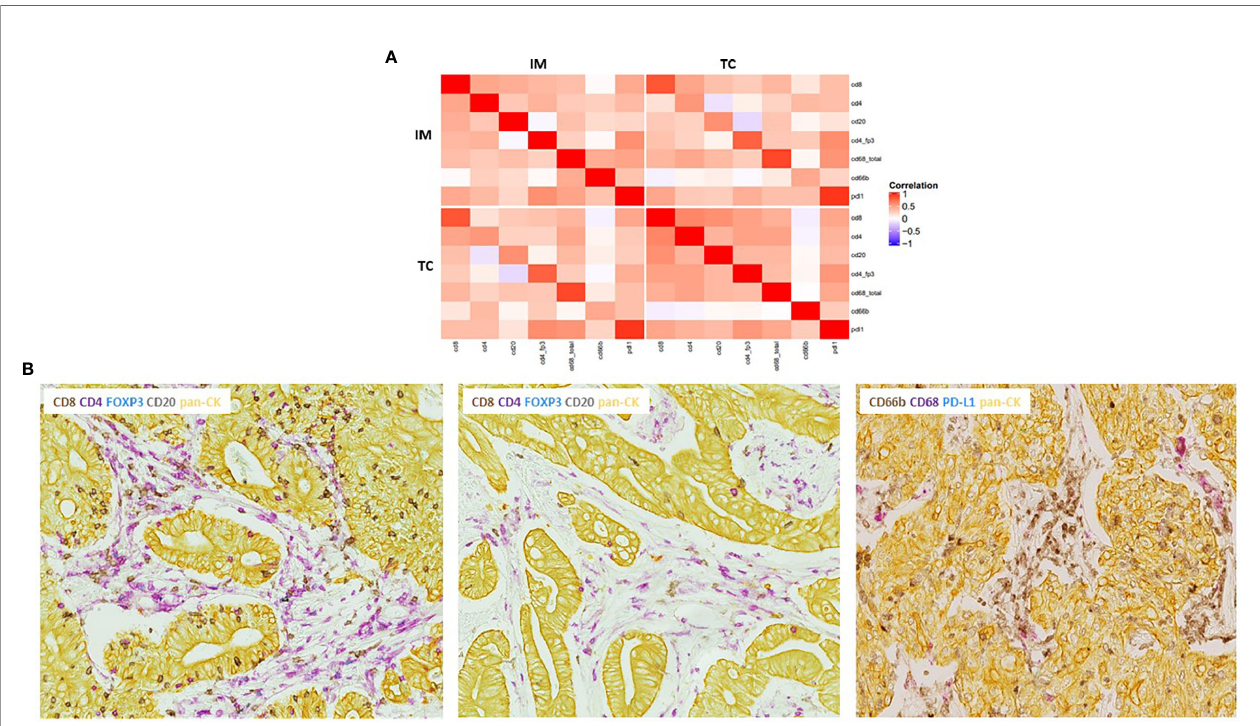
FIGURE 4 | Correlations between immune markers in colon cancer patients. (A) Heatmap of Pearson correlation coef fi cients between individual immune markers at the invasive margin (IM) and tumor center (TC) based upon the combined tumor-in fi ltrating and stromal immune cell densities. Red color indicates strong positive correlation, blue indicates strong negative correlation, and white indicates no correlation. (B) Representative images of existing correlations. Left: tumor slide from the IM of a CRP-low MSS tumor stained with the adaptive IHC panel showing a strong correlation between adaptive immune cells, particularly CD8+ and CD4+ T cells. Middle: tumor slide from the TC of the same patient as in the left panel showing modest adaptive immune in fi ltration illustrating a low correlation between immune cells at the IM and TC. Right: tumor section stained with the innate IHC panel showing vigorous neutrophil in fi ltration, with no correlations with any other marker. *Combined tumor-in fi ltrating and stromal immune cell densities.